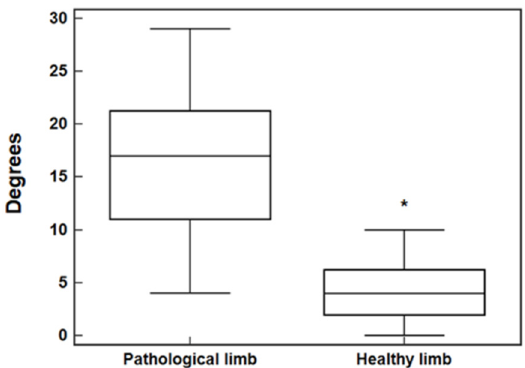
Figure 2. Difference between healthy and pathological limb. Values, expressed in degrees, of dynamic adaptive valgus (16.3 ± 6.8° 95% CI 14.04 to 18.55; 4.2 ± 3.1° 95% CI 3.15 to 5.21, n = 38, *